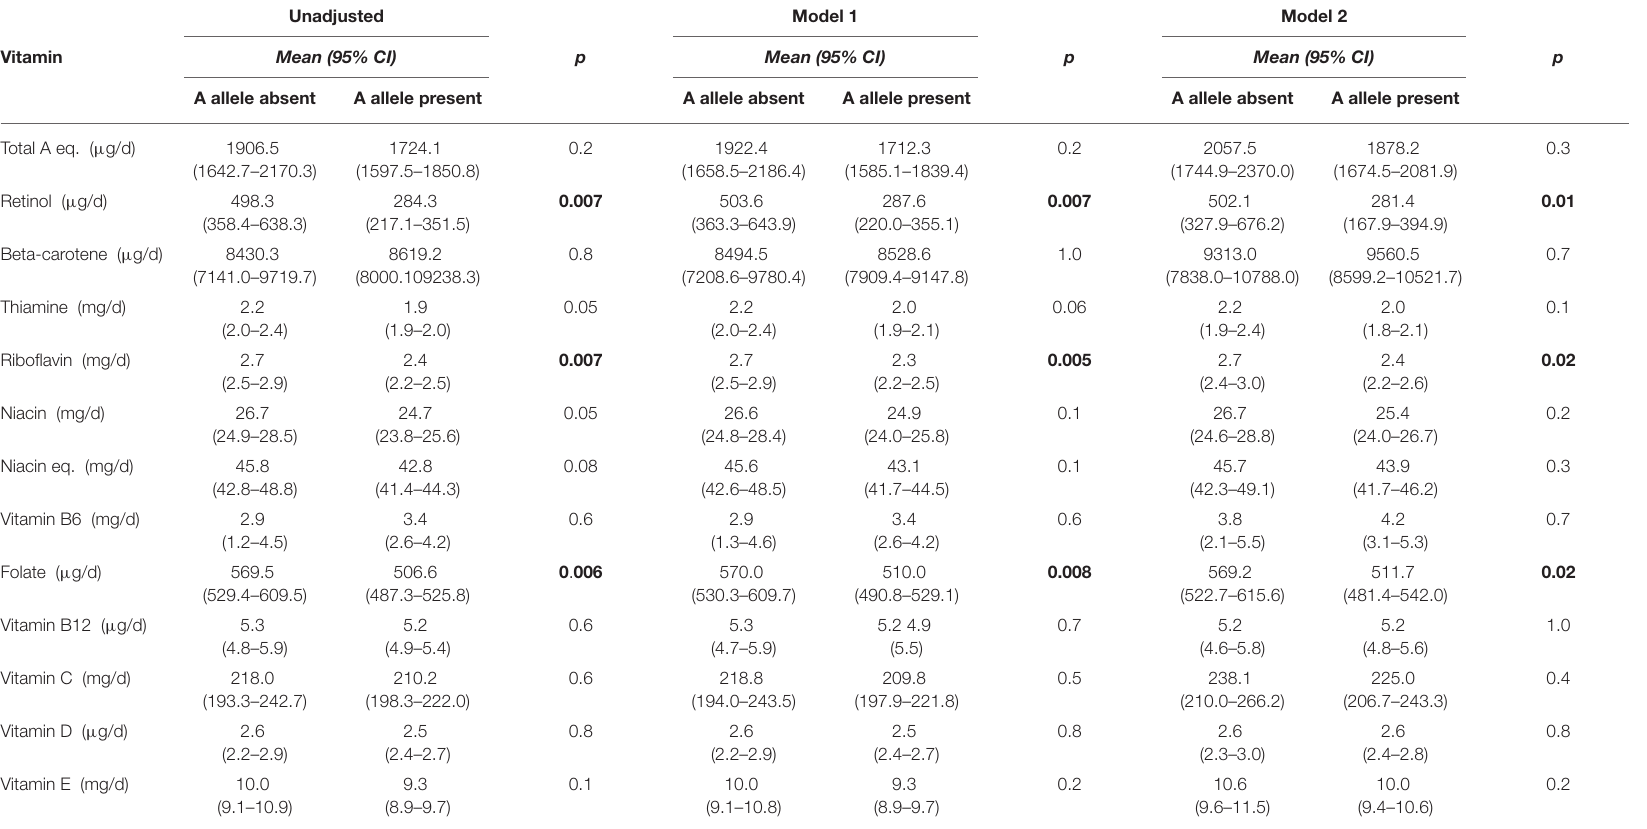
TABLE 2 | Estimated dietary vitamin intakes vary by the presence of the KCNJ2 -A allele in unadjusted and adjusted